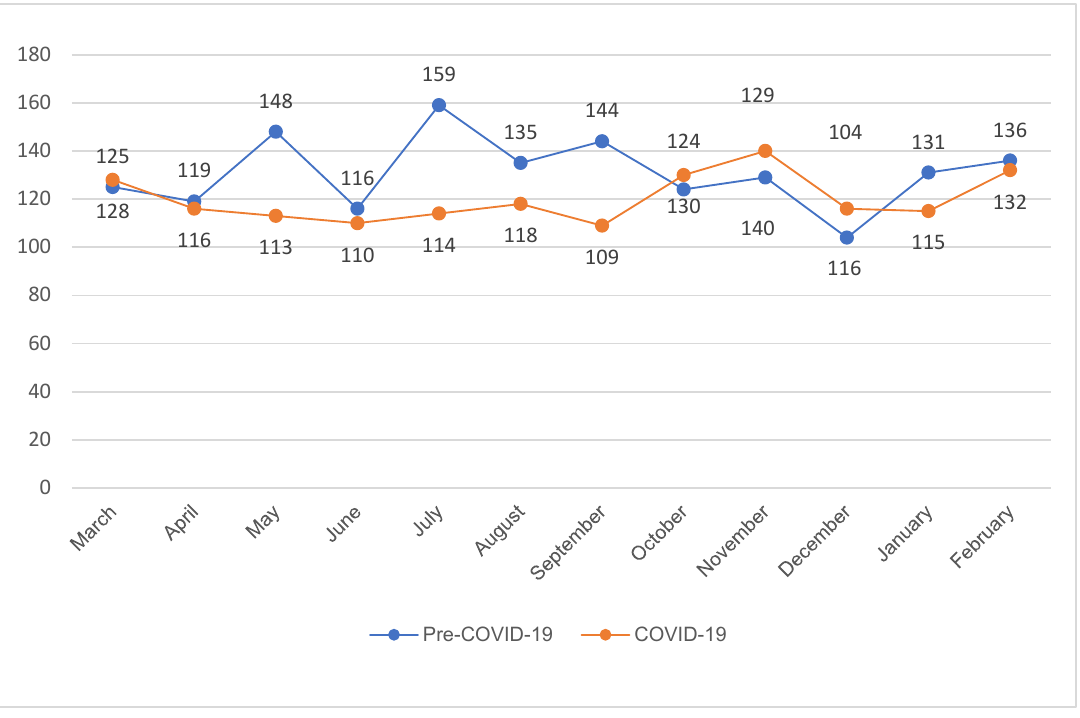
Figure 2. The monthly number of patients using EMS for acute stroke symptoms. COVID-19; coronavirus disease-19.